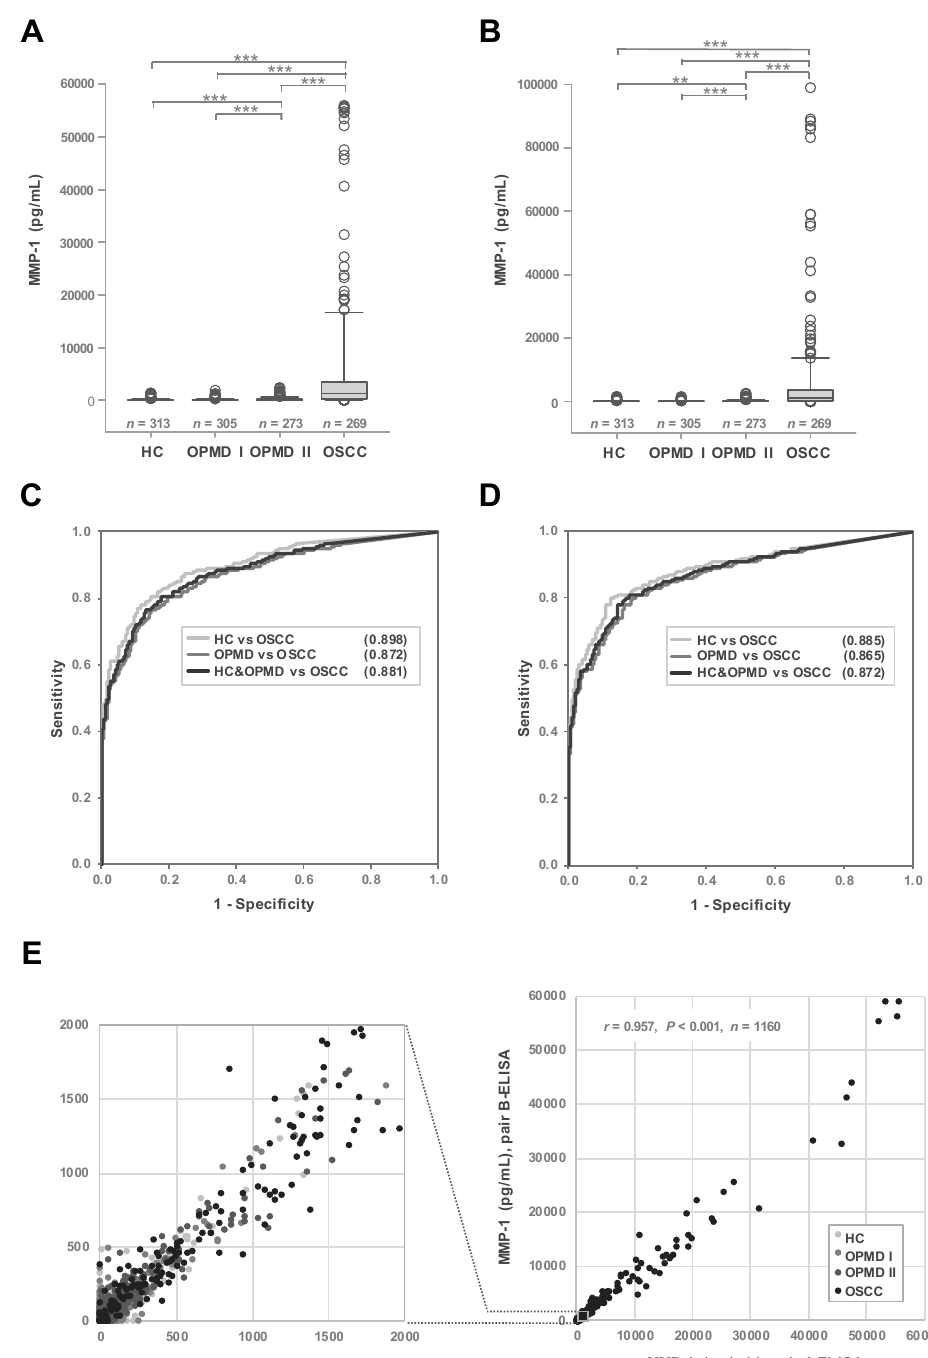
Figure 1. Matrix metalloproteinase-1 (MMP-1) levels in saliva from 1160 clinical specimens. ( A , B ) Salivary levels of MMP-1 in healthy controls, oral potentially malignant disorders (OPMD) I, OPMD II, and oral squamous cell carcinoma (OSCC) patients were determined using two pairs of enzyme-linked immunosorbent assays (ELISAs), pair A ( A ) and B ( B ), as described in Section 2. ** p < 0.01. *** p < 0.001. ( C , D ) Receiver operating characteristic (ROC) curve showing the diagnostic efficacy of salivary MMP-1, determined using pair-A ELISA ( C ) and pair-B ELISA ( D ) for OSCC versus non-cancerous groups (healthy controls (HC) and OPMD). ( E ) Correlation between levels of salivary MMP-1 in HC, OPMD I, OPMD II, and OSCC patients, determined using pair A- and pair B-ELISA, as described in Section 2 (Pearson correlation, r = 0.957, p < 0.001). The boxed image in the right panel is enlarged and shown on the left.